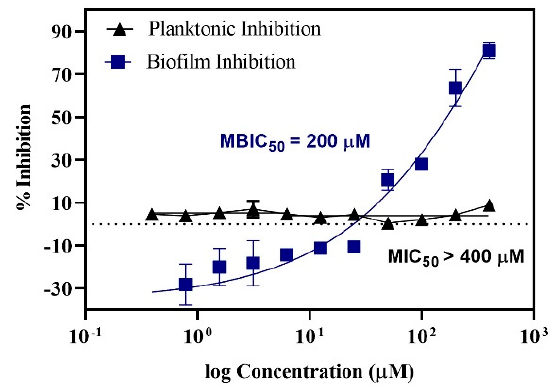
Figure 1. Dose response curve representing the action of Baicalein on S. mutans . MBIC 50 (Minimum Biofilm Inhibitory Concentration) = 200 µ M; MIC 50 (Minimum Inhibitory Concentration) > 400 µ